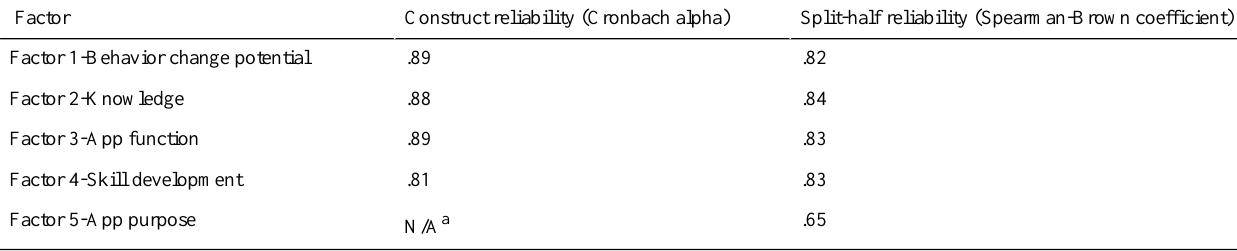
Table 2. Construct and split-half reliability of factors evaluating app quality (n=75 evaluations).